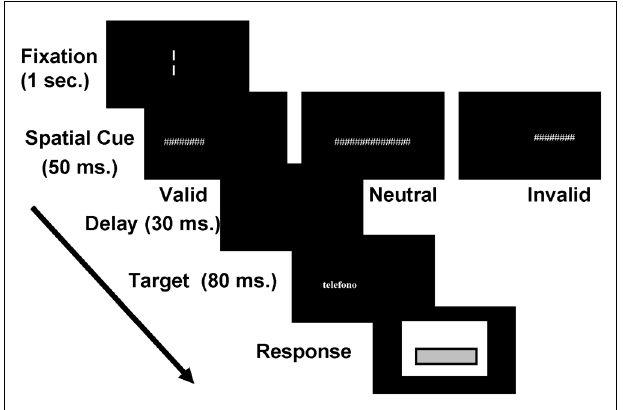
30 ms of delay the target string was presented for 80 ms.The response window remained on the screen until participants typed in the perceived